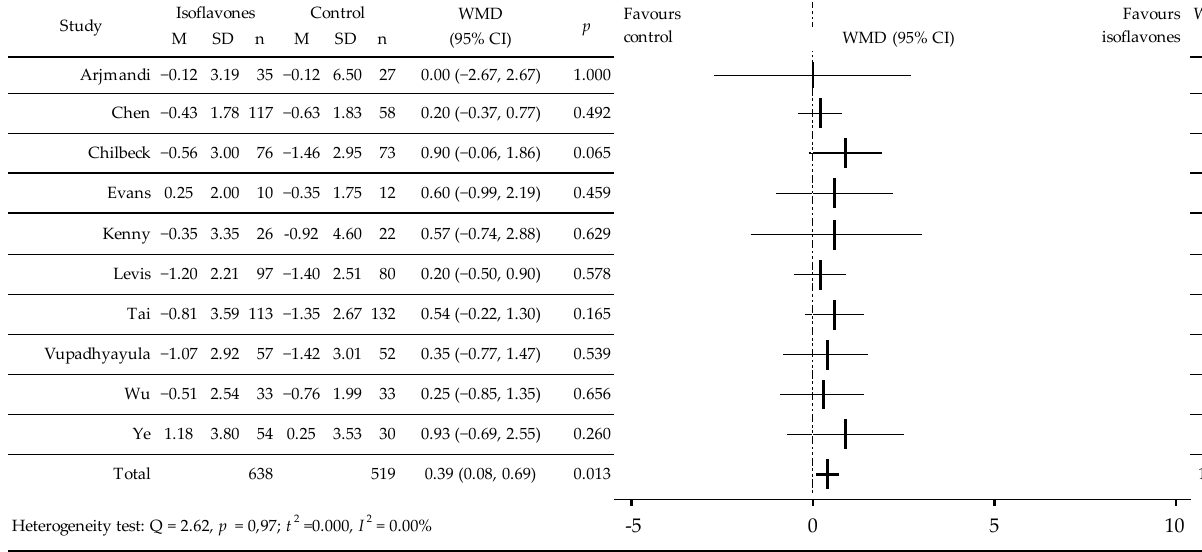
Figure 4. Effect of soy isoflavones on bone mineral density of proximal femur in postmenopausal women compared to placebo [28,31–33,35,38–42]. M, mean change from baseline (%); SD, standard deviation; n, size of the study group; WMD, weighted average difference (%); CI, confidence interval; horizontal lines correspond to 95% CI.